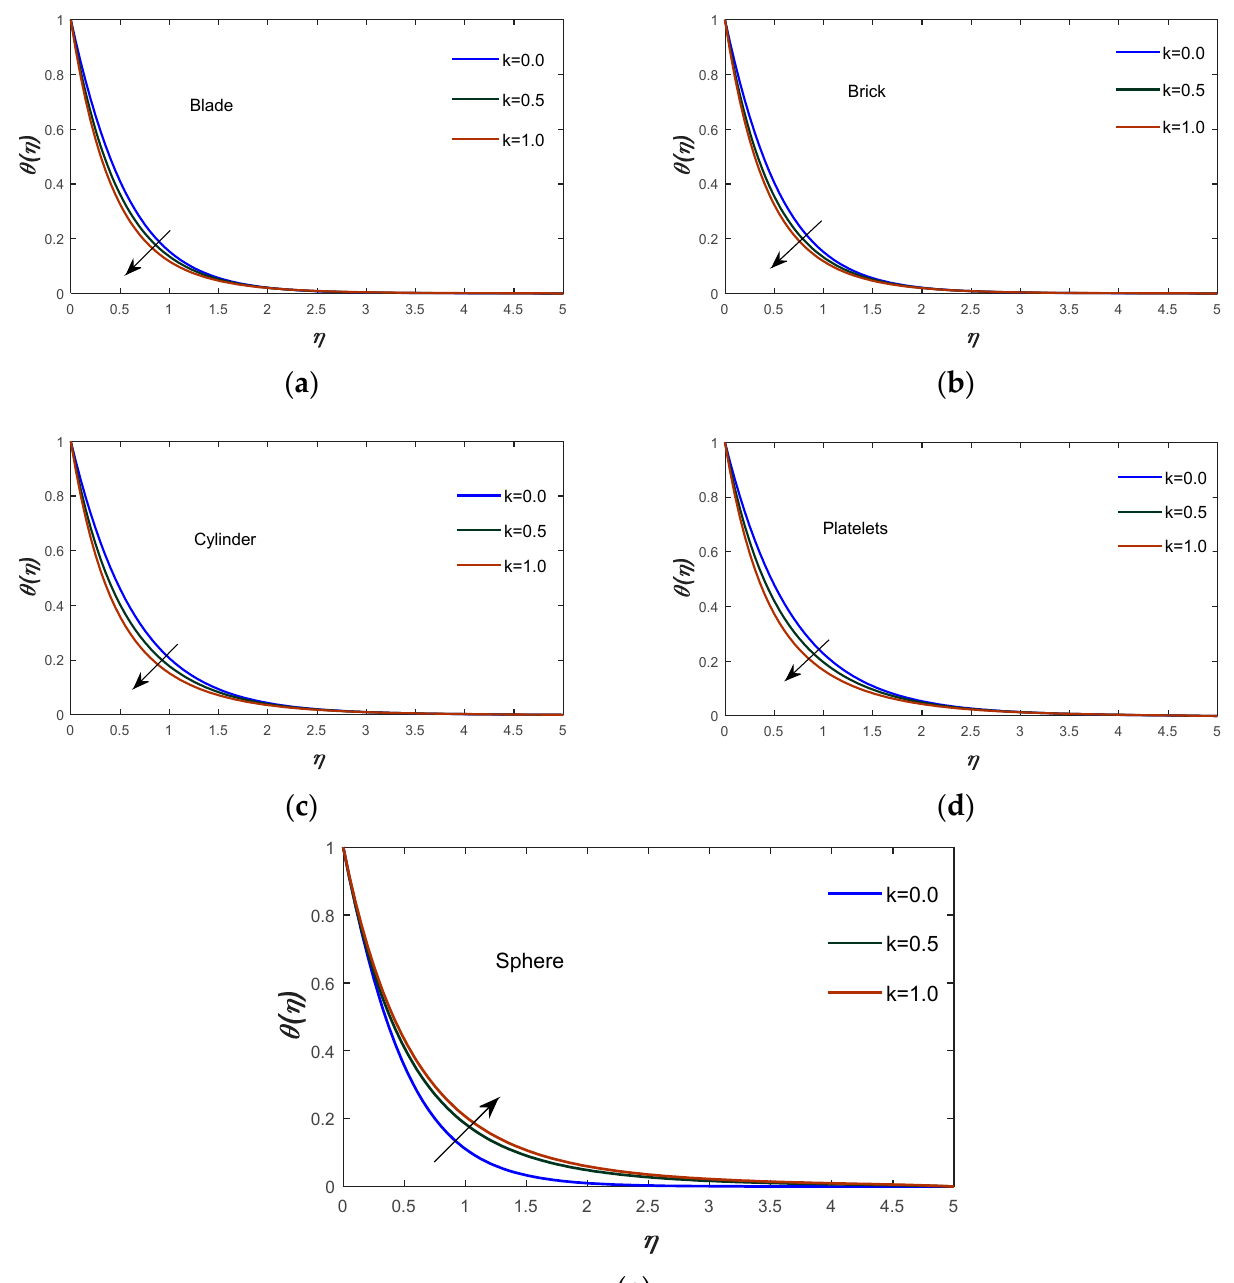
Figure 7. ( a – e ). Impact of 𝐾 on 𝜃(𝜂) by using various shapes factors of nanoparticles for fixed 𝑀 = 1.0, 𝑃𝑟 = 6.0, 𝑆 = 0.5, 𝐸𝑐 = 1.0, 𝜑 = 0.02 .